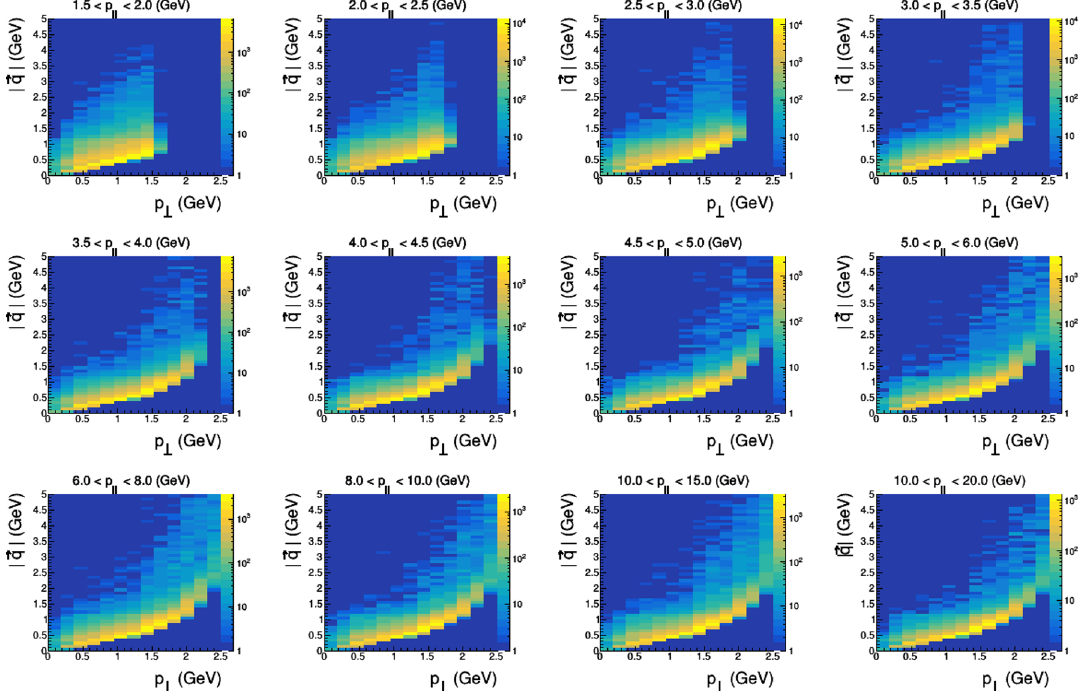
bins as in figure 6. The color k